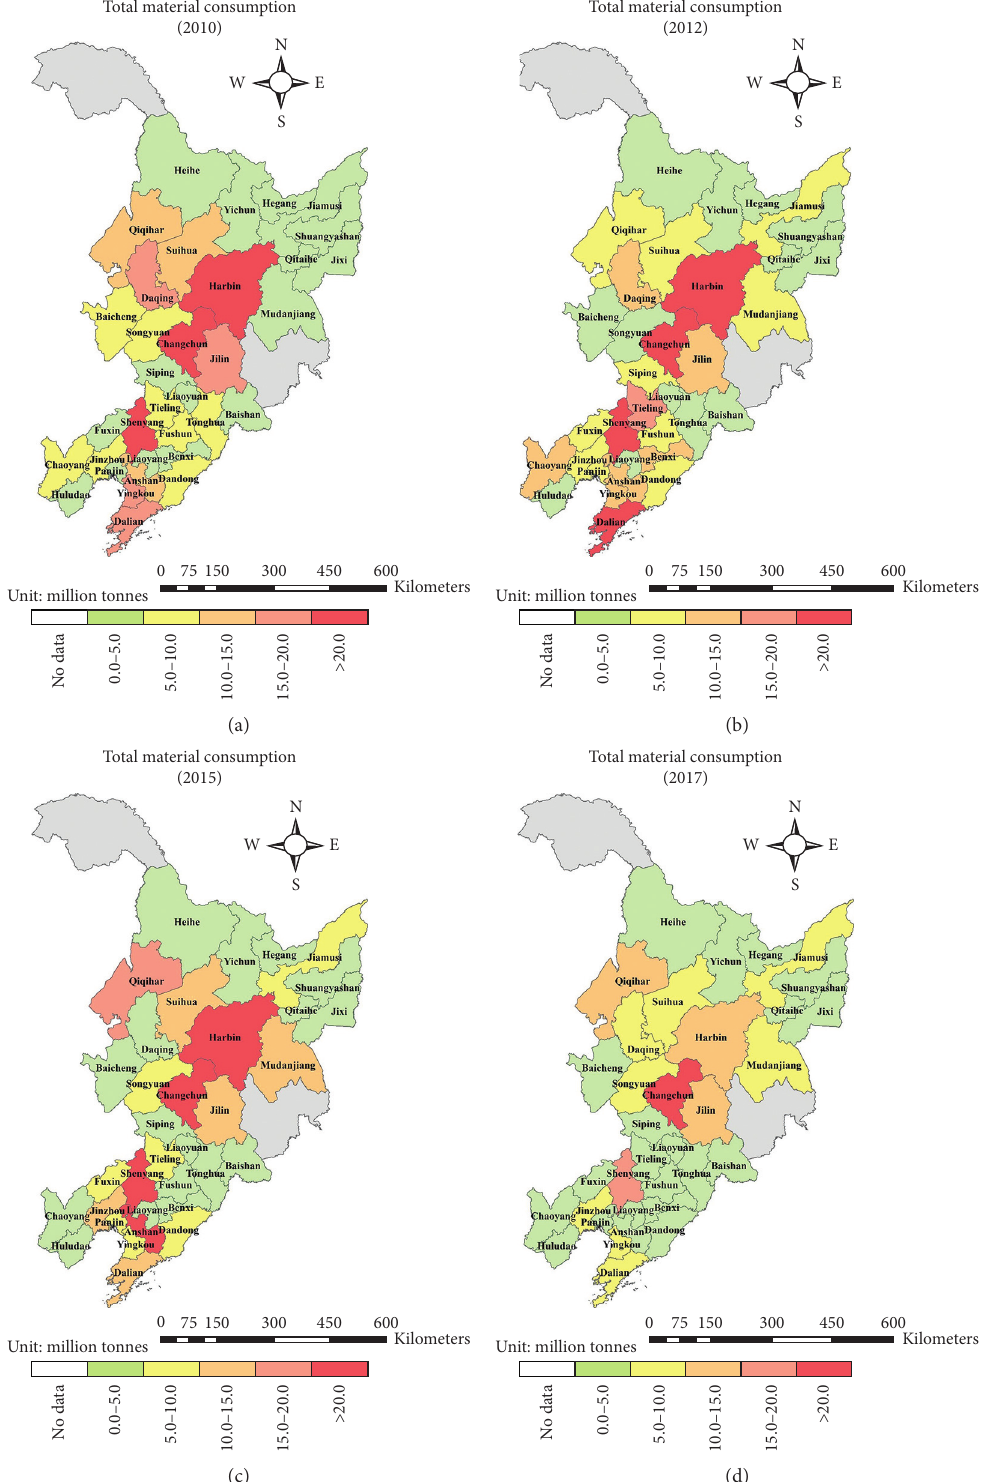
Figure 5: Spatial patterns of the total material consumption of infrastructure construction of 34 cities in Northeast China in 2010, 2012, 2015, and